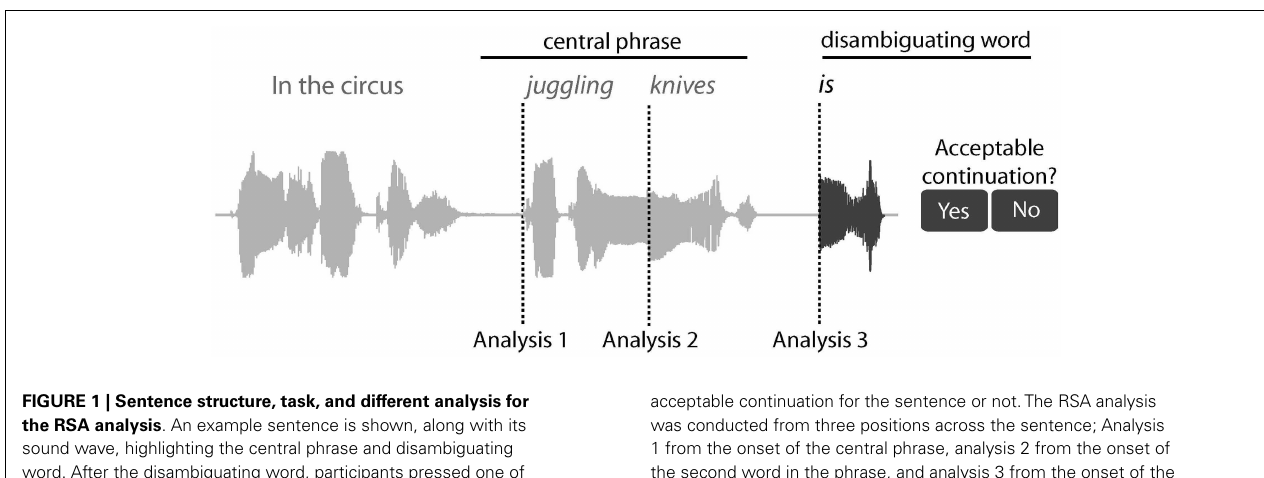
FIGURE 1 | Sentence structure, task, and different analysis for the RSA analysis . An example sentence is shown, along with its sound wave, highlighting the central phrase and disambiguating word. After the disambiguating word, participants pressed one of two buttons to indicate whether the disambiguating word was an